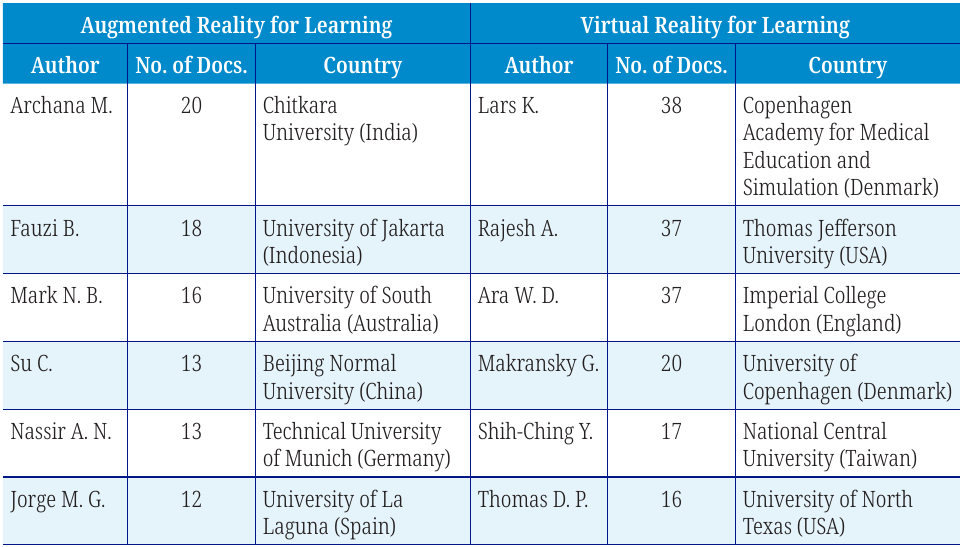
Table 4. Top 20 authors with most publications in AR/VR for